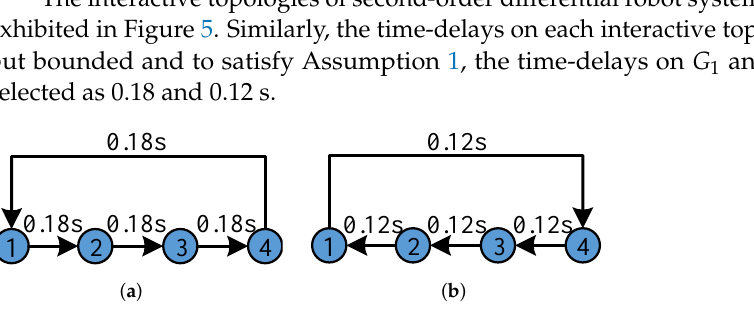
Figure 5. Interactive topologies of second-order differential robot system (27). ( a ) G 1 , ( b ) G 2